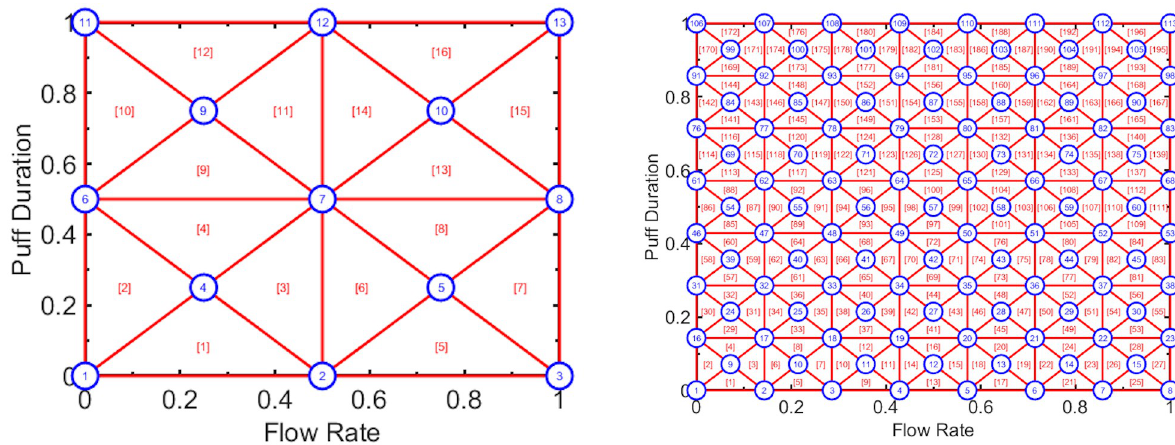
Fig 2. High fidelity emission topography protocols composed of 61 flow conditions (left panel, pattern 1-3-5-7-9-11-9-7-5-3-1) and 113 flow conditions (right panel, pattern 1-3-5-7-9-11-13-15-13-11-9-7-5-3-1). The horizontal and vertical axes represent the marginal cumulative distribution functions of natural environment observed puff flow rate and duration,